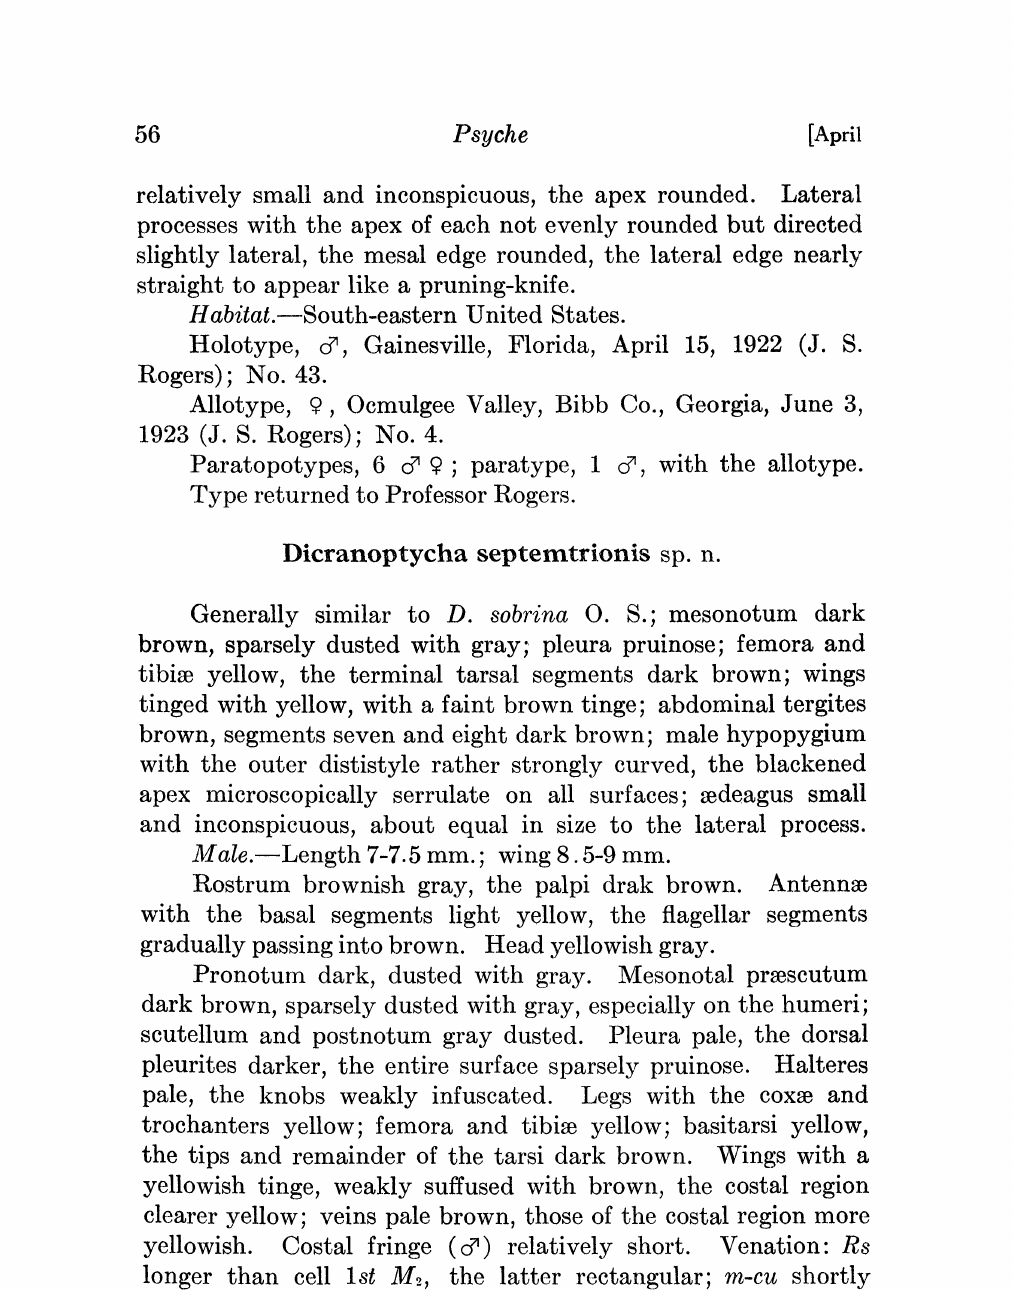
dark brown, sparsely dusted with gray, especially on the humeri; scutellum and postnotum gray dusted. Pleura pale, the dorsal pleurites darker, the entire surface sparsely pruinose. Halteres pale, the knobs weakly infuscated. Legs with the coxm and trochanters yellow; femora and tibim yellow; basitarsi yellow, the tips and remainder of the tarsi dark brown. Wings with a yellowish tinge, weakly suffused with brown, the costal region clearer yellow; veins pale brown, those of the costal region more